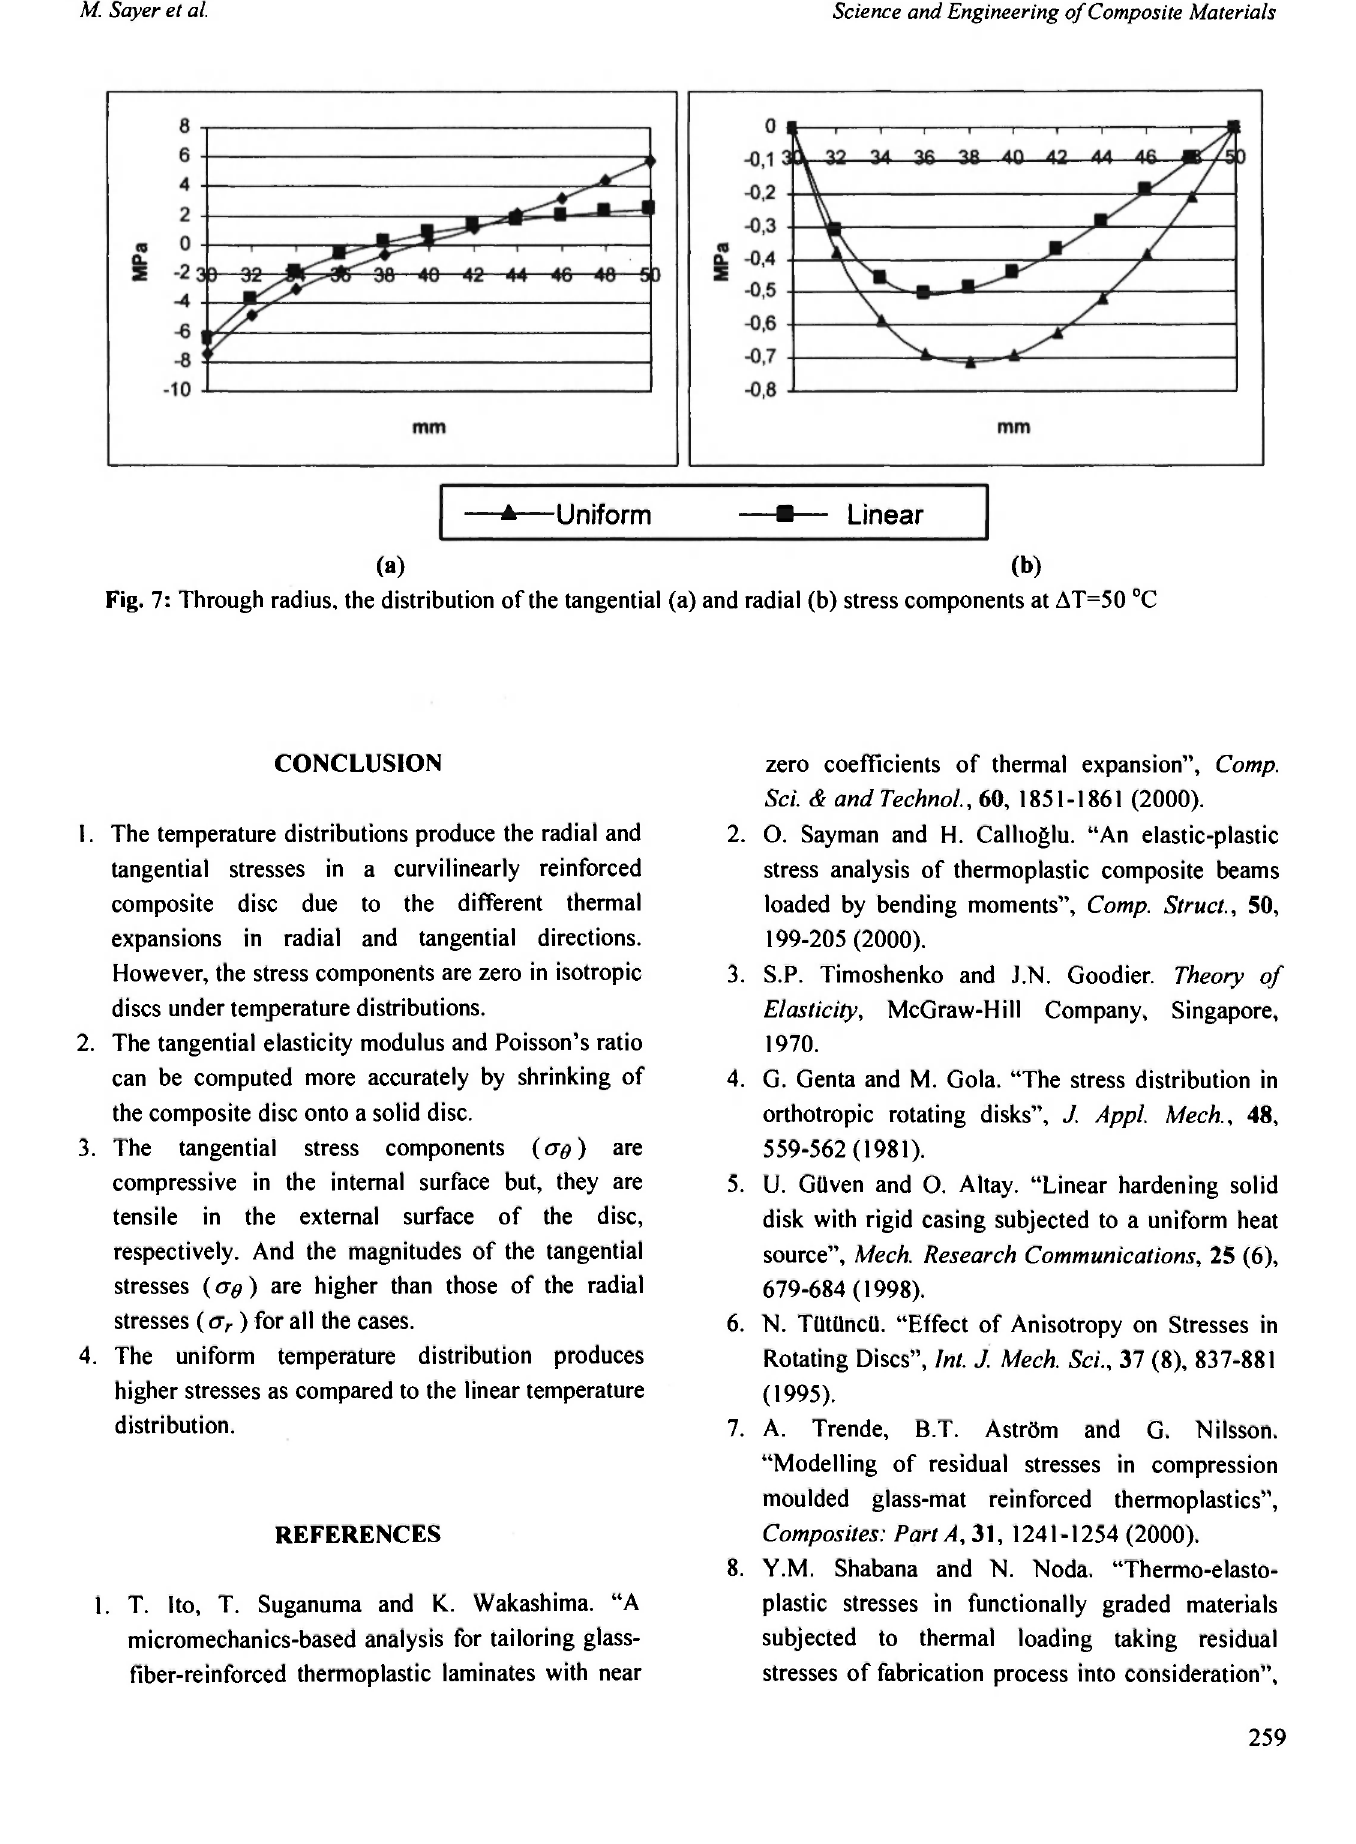
Fig. 7: Through radius, the distribution of the tangential